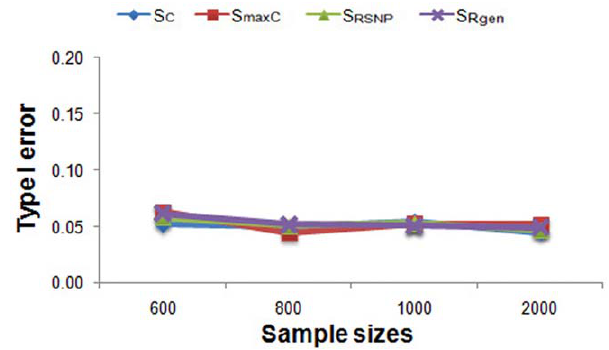
Figure 2. Type I error rate simulating results of PCA-based MPPAS using S C , S max C , S Rgen and S RSNP statistics under various sample sizes.